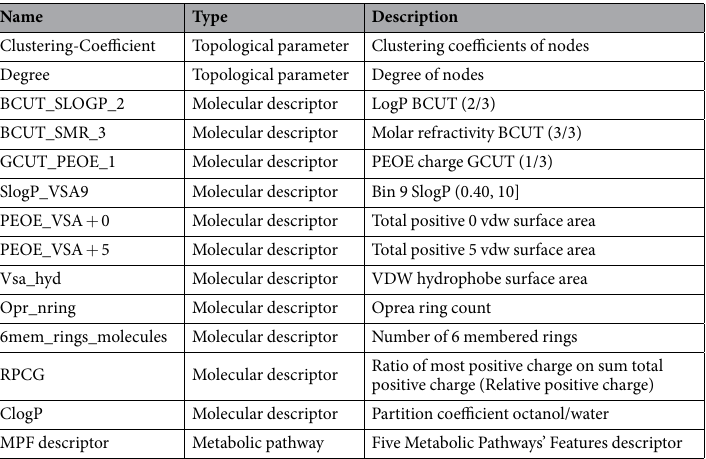
Table 2. The selected 14 variables of the optimal variable